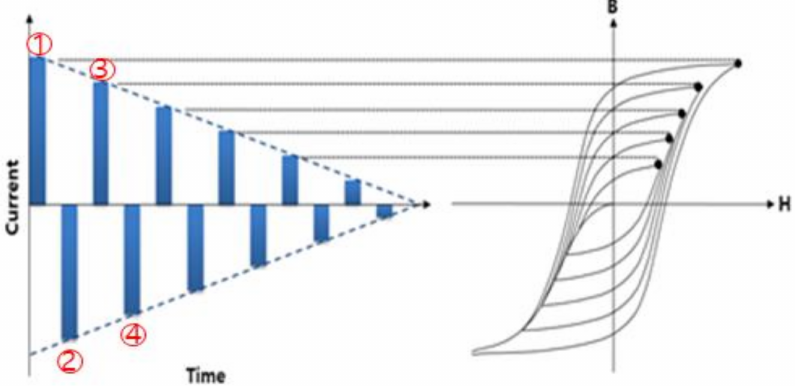
Figure 2. The principle of demagnetization and hysteresis curve of ferromagnetic material.